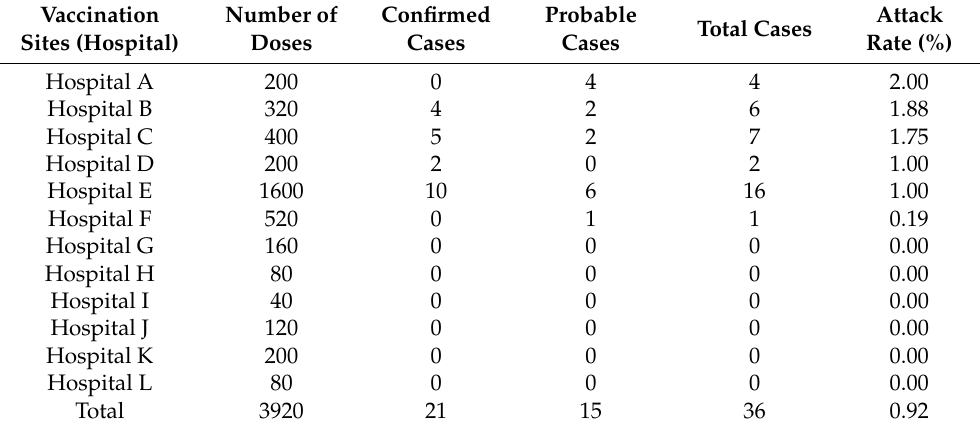
Table 1. Distribution of CoronaVac vaccine and number of cases by vaccination sites.